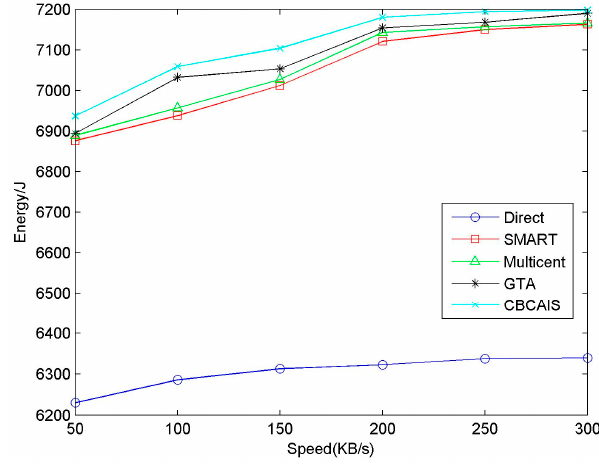
Figure 24. Energy for varying transmission speeds.